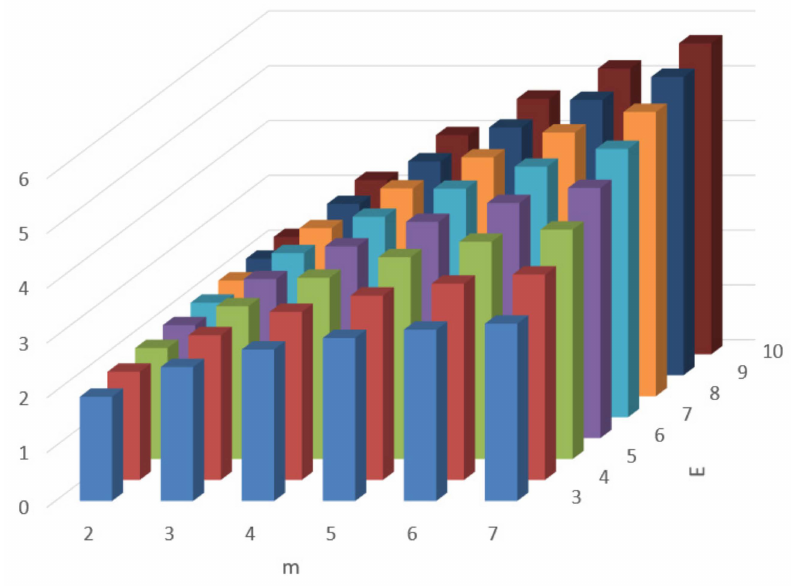
Figure 6. The values of the estimate (5) for a group of polynomials over GF ( 2 3 )